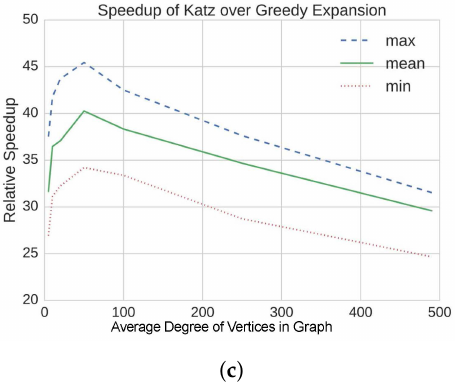
Figure 1. The speedup of the personalized Katz centrality method compared to greedy expansion is shown for SBM graphs with different parameters. ( a ) The number of vertices n in the graph varies, with d = 20 and k = 2. ( b ) The number of communities k in the graph varies, with n = 47104 and d = 20. ( c ) The average vertex degree d varies, with n = 1000 and k =